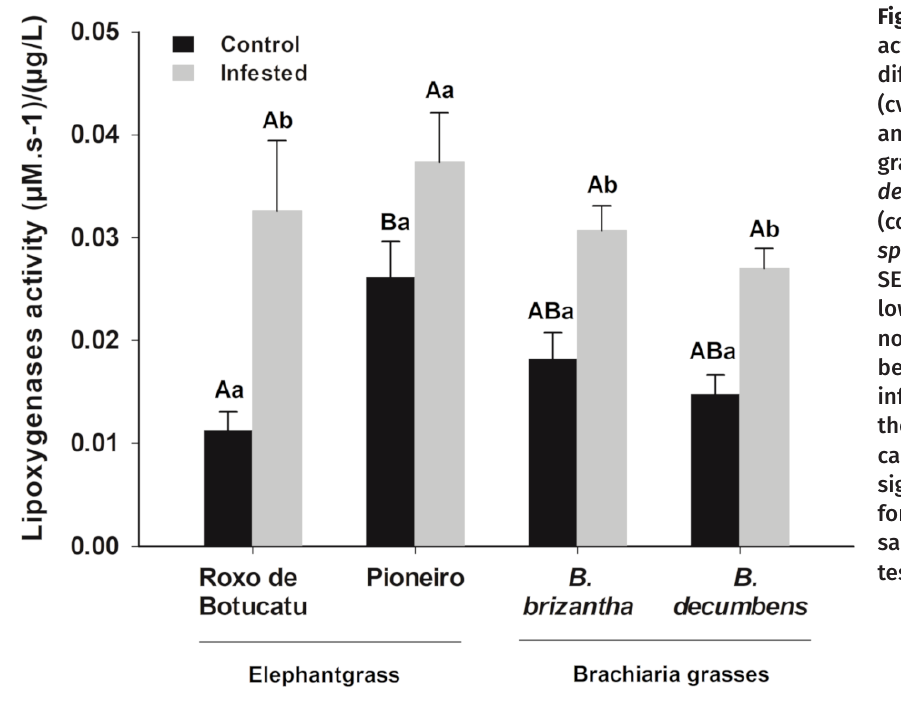
Figure 1. Lipoxygenase activities in leaves of different forage grasses (cvs. Roxo de Botucatu and Pioneiro of elephant grass, B. brizantha , and B. decumbens ) infested or not (control) with Mahanarva spectabilis . Bars (mean ± SE; n = 4) with the same lowercase letters indicate no significant difference between control and infested treatments and those followed by the same capital letters indicate no significant difference among forage grasses within the same treatment (Tukey’s test: P <